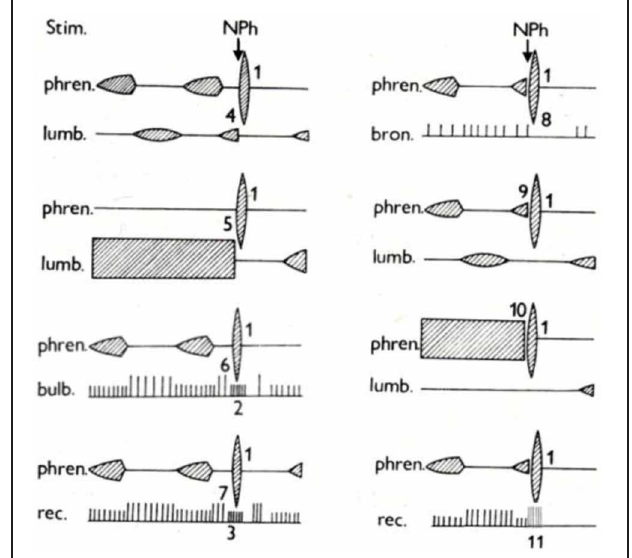
FIGURE 3 | Specific activity in various neural structures evoked by NPh stimulation in cats. Schematic illustration of changes evoked in activity of motoneurones of the phrenic nerve (phren.), lumbar nerve (lumb.), and recurrent laryngeal nerve (rec.), of bulbar inspiratory and expiratory neurons (bulb.) and of bronchoconstrictor fiber of vagus (bron.) by mechanical stimulation (Stim.) of nasopharynx (NPh) in anesthetized cats. The numbers indicate development of specific activity in the phrenic nerve (1), in inspiratory neurons of medulla oblongata (2) and in inspiratory neurons of recurrent laryngeal nerve (3) during expiration. Inhibition of spontaneous (4) and tonic (5) expiratory activity in the lumbar nerve, bulbar expiratory neurons (6), and recurrent laryngeal nerve (7) during expiration. Inhibition of bronchomotor fibers of vagus (8). Replacement of spontaneous (9) and tonic (10) inspiratory activity in the phrenic nerve and recurrent laryngeal nerve (11) by specific activity during inspiration. Adapted from Tomori et al.